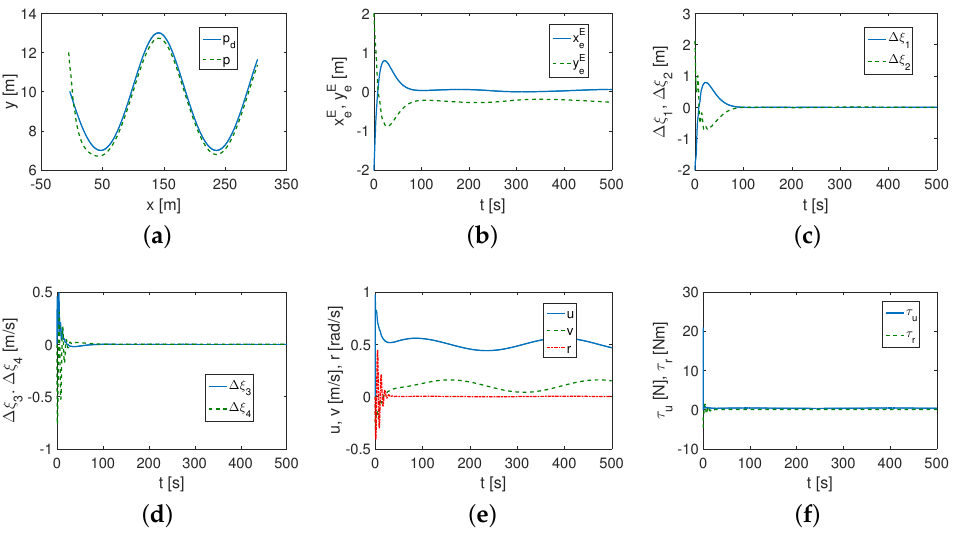
Figure 12. Simulation results for Kambara, CL controller and cycloid trajectory: ( a ) desired and realized trajectory; ( b ) position errors; ( c ) position error states; ( d ) velocity error states; ( e ) velocities; ( f ) applied force and torque.